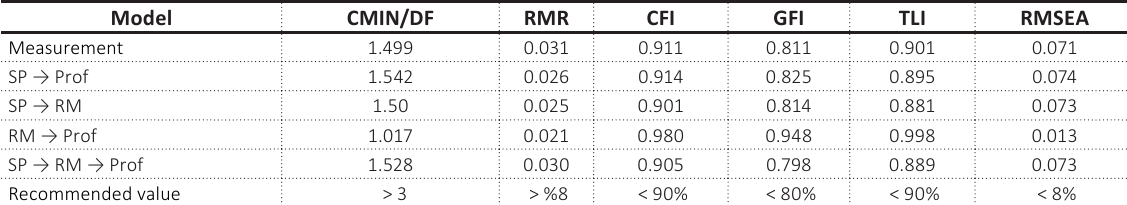
Table 3. Hypotheses testing